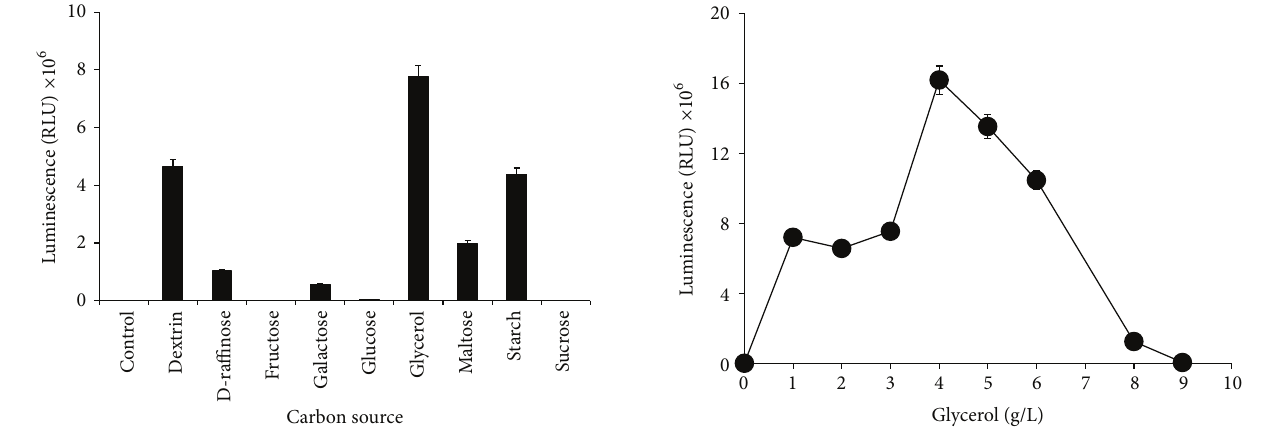
Figure 3: Effects of glycerol concentration on bioluminescence production of Photobacterium sp. strain MIE. The cultures were grown in luminescence media containing different concentration of glycerol incubated in orbital shaker (100rpm) for 12 hours at room temperature. Data is mean ± standard error of the mean ( 𝑛 = 3